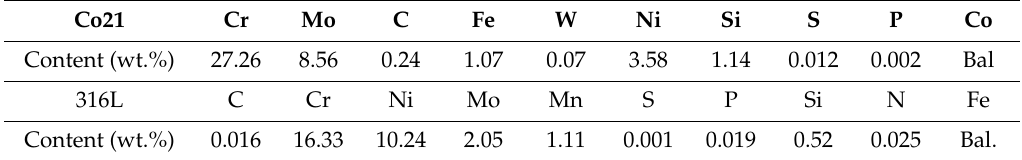
Content (wt.%) Table 2. The parameters of laser metal deposition. Order Power